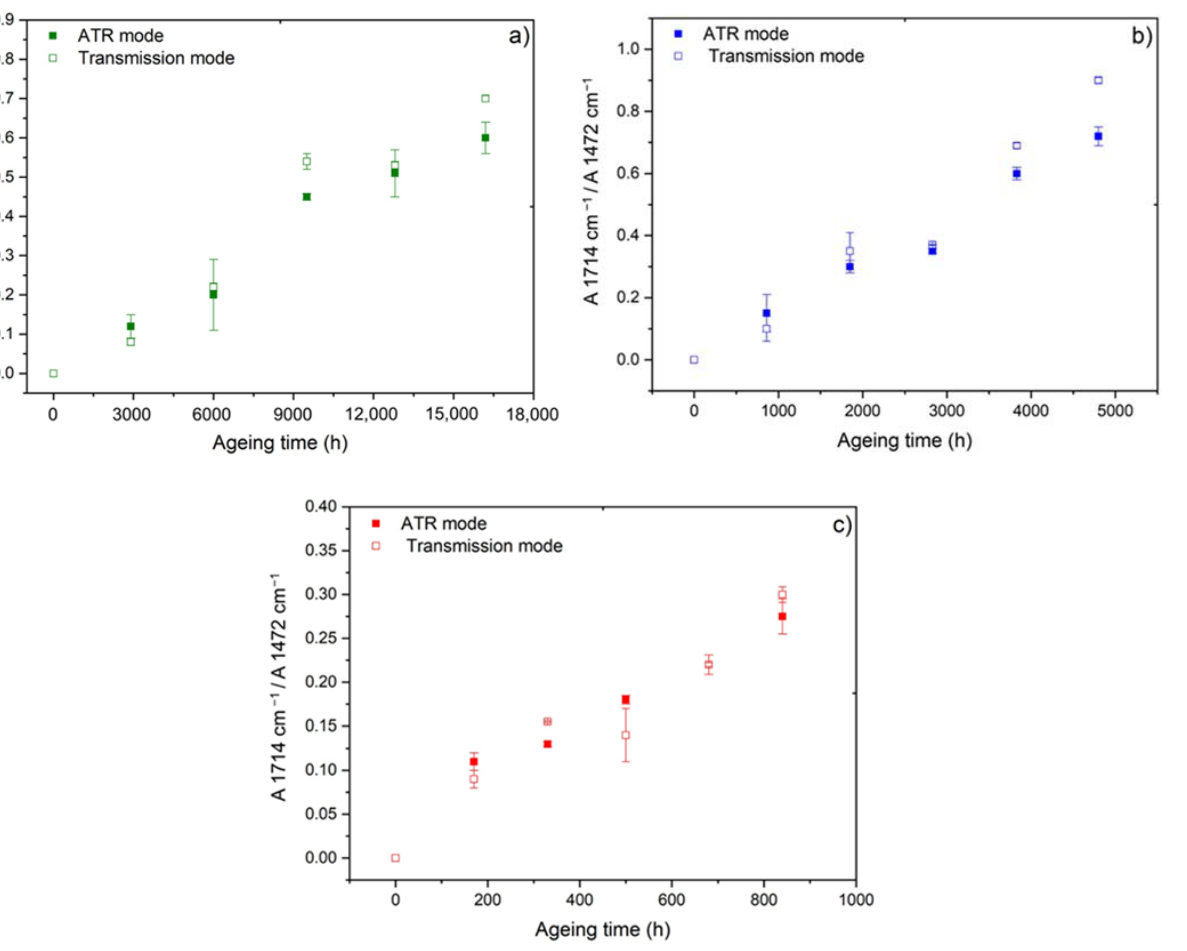
Figure 3. Changes in the carboxylic acid index measured with two different IR methods (i.e., in ATR and transmission modes) for the unfilled Si-XLPE matrix during its radio-thermal exposure in air under 8.5 Gy ∙ h − 1 at 47 °C ( a ), under 77.8 Gy ∙ h − 1 at 47 °C ( b ), and under 400 Gy ∙ h − 1 at 21 °C ( c ).